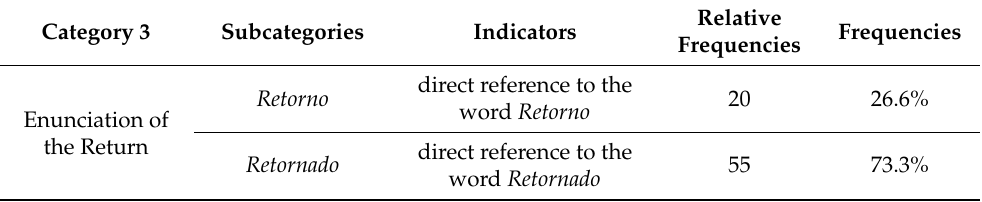
Table 4. Absolute and relative frequencies for the category “Enunciation of